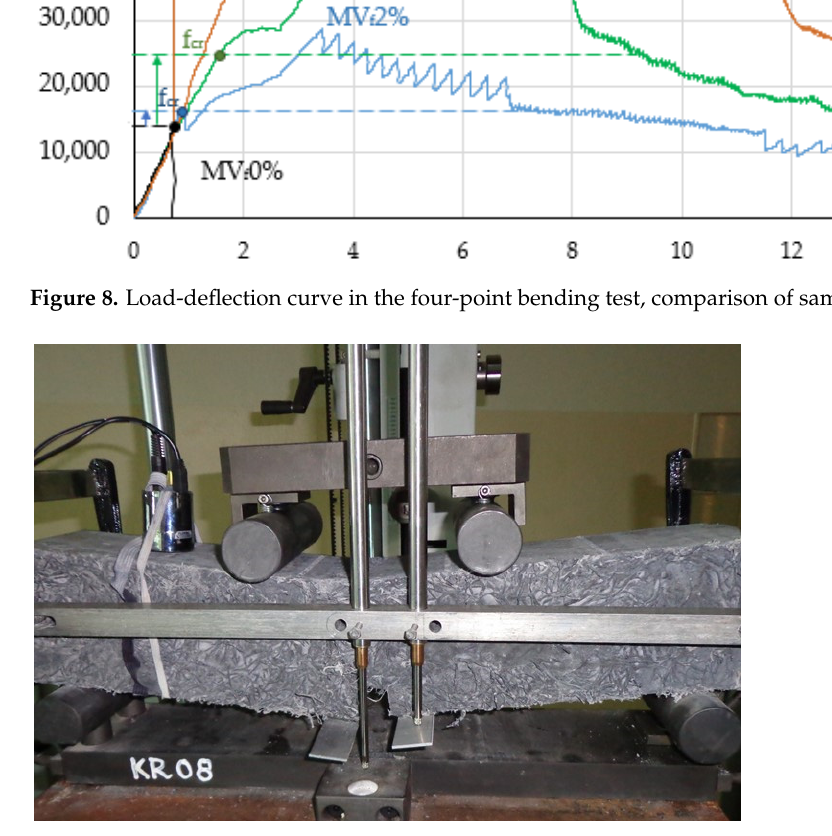
Table 2. Tested specimens, a compilation of data in relation to characteristic points f x